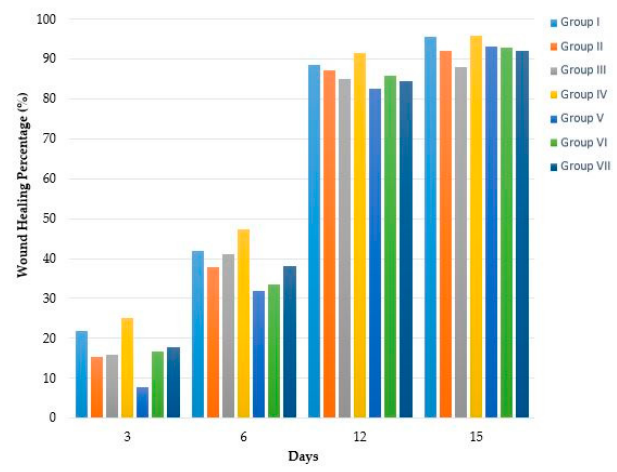
Figure 2. Wound healing percentage (%) of compared